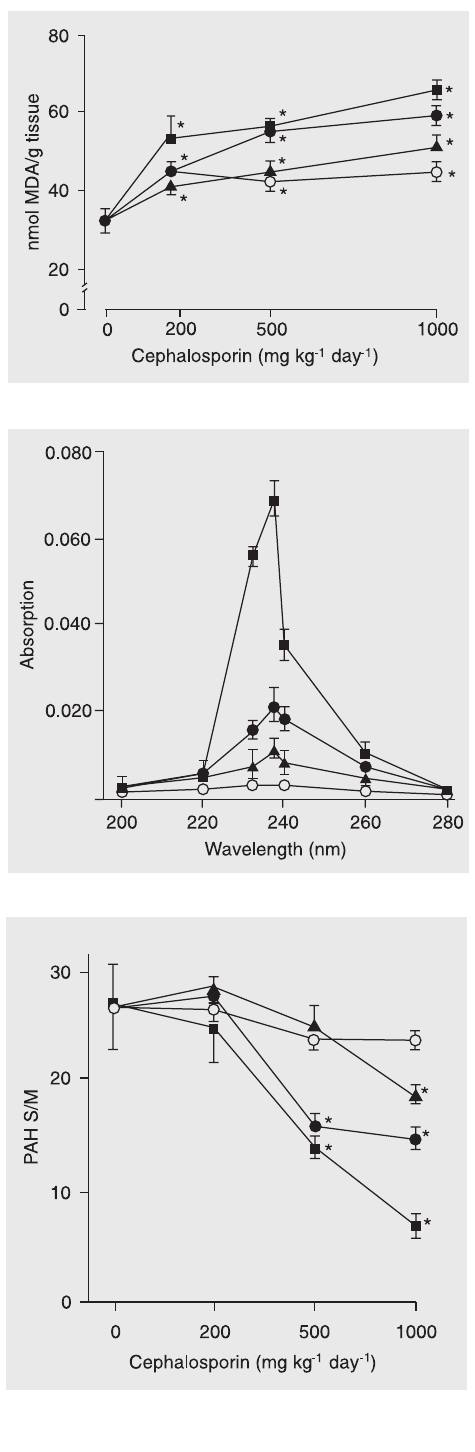
Figure 3. Dose-dependent in- crease of malondialdehyde (MDA) content in the renal cortex after ip cephalosporin adminis- tration for 4 days. Squares = cephaloridine; filled circles = cephalothin; triangles = cefotiam; open circles = cefotaxime. Data are reported as means ± SD for at least 5 rats. *P < 0.05 com- pared to control (Student- Neumann-Keuls test).